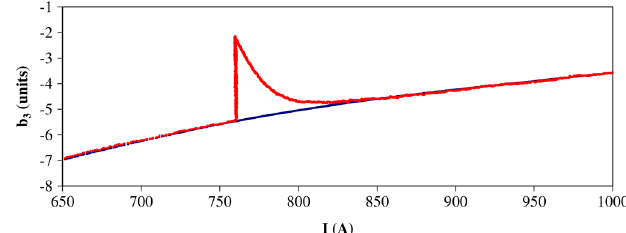
FIG. 7. (Color) (red) The b decay during the injection plateau 3 of an LHC cycle (at 760 A) and the subsequent snap-back when the current begins to ramp, measured on LHC dipole 2211. hysteresis curve without an injection (blue) b 3